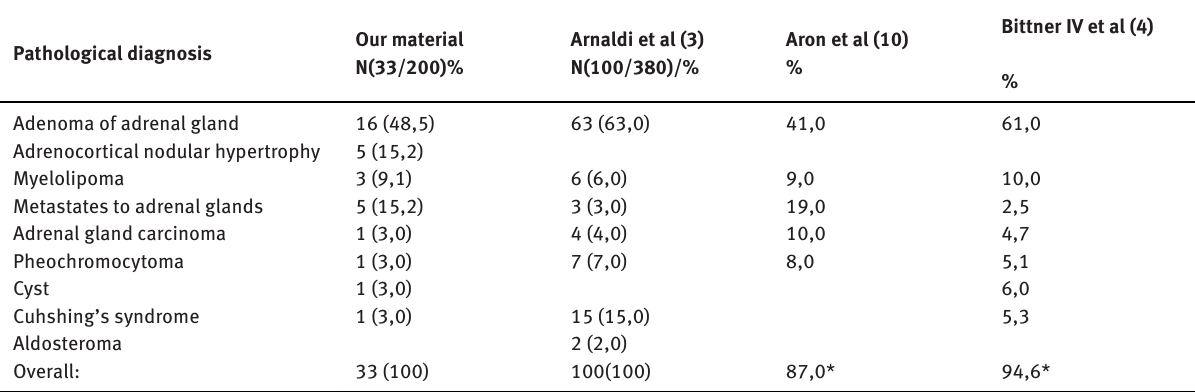
Table 1: Comparison of results from our materials and other authors Pathological diagnosis